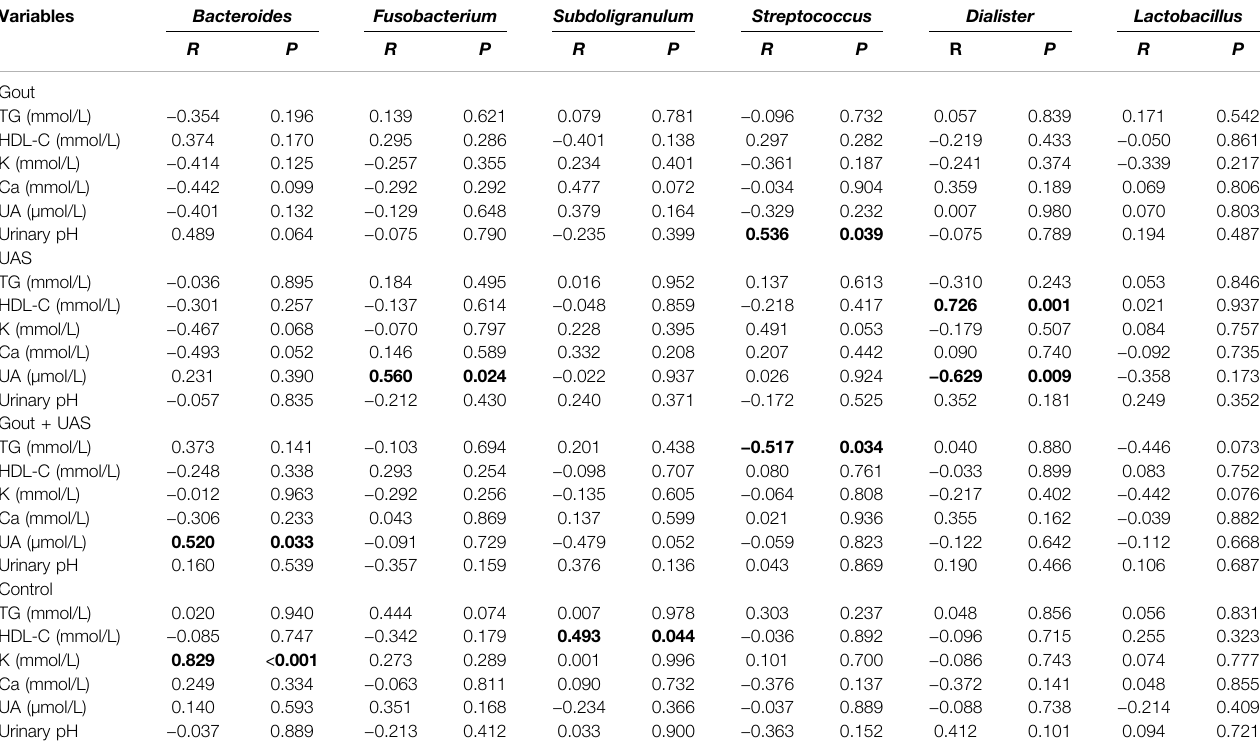
TABLE 4 | | Spearman correlation coef fi cient of signi fi cant different biochemical parameters and major bacterial genera in each group.